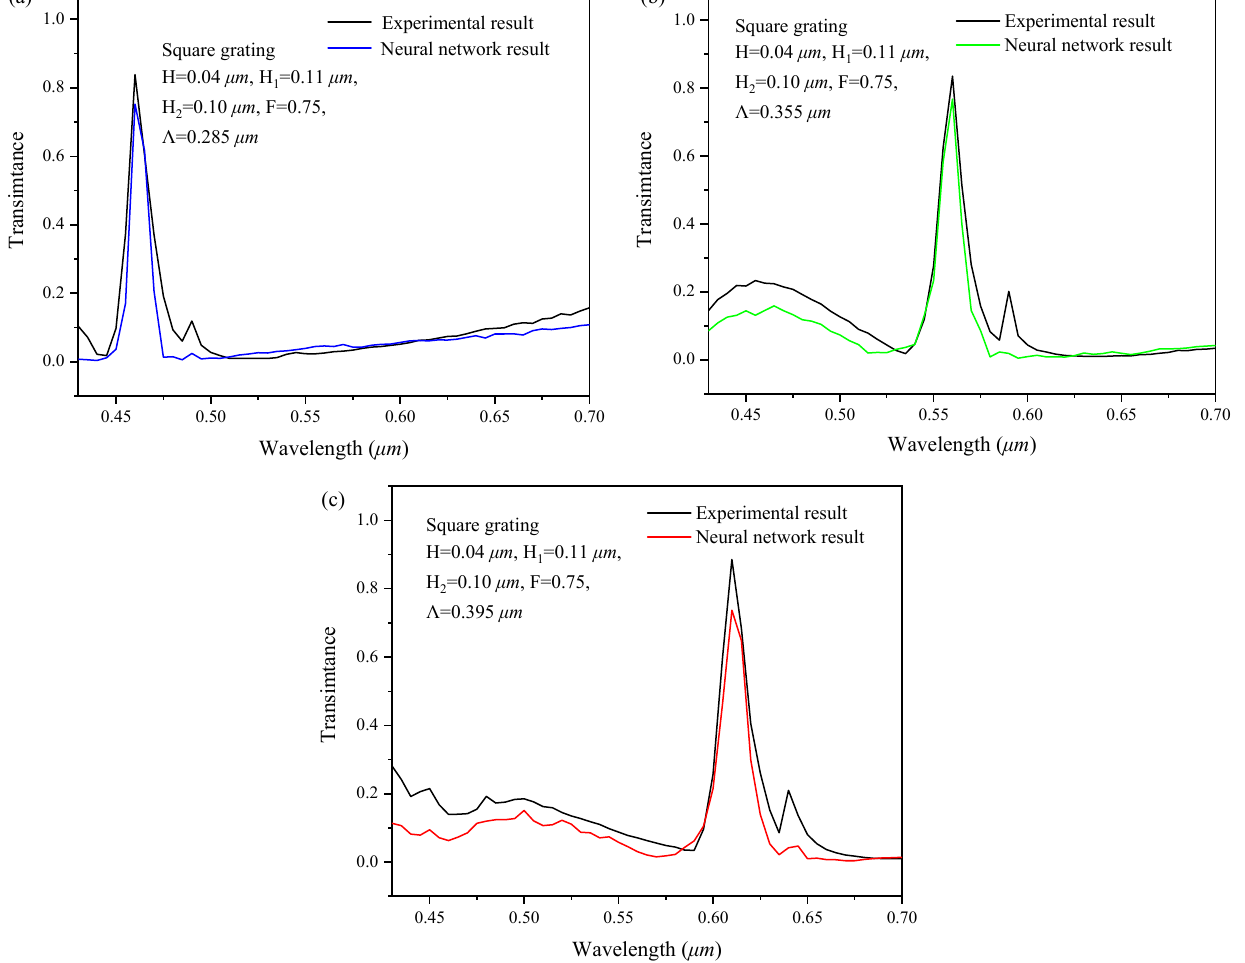
Figure 9. Comparison of the forward simulation with the experimental results in the literature [22] (peak wavelength: ( a ) 0.46 µm ( b ) 0.56 µm ( c ) 0.61 µm).